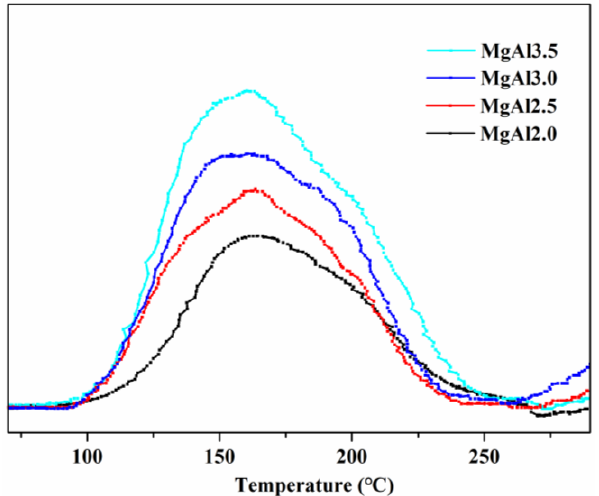
Figure 6. CO 2 -TPD profiles of LDHs with different Mg/Al molar ratios. Table 2. Desorption peak temperature and area of LDHs with different Mg/Al molar ratios.